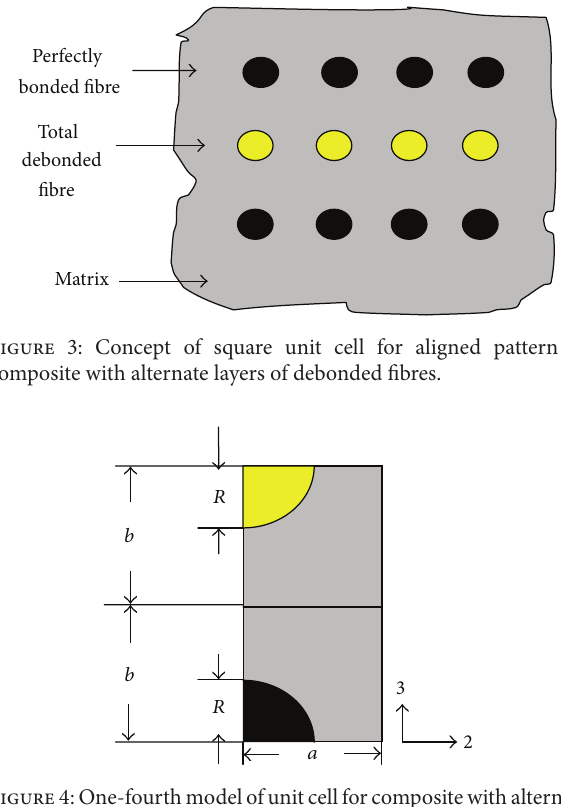
Figure4:One-fourthmodelofunitcellforcompositewithalternate layers of debonded fibres.